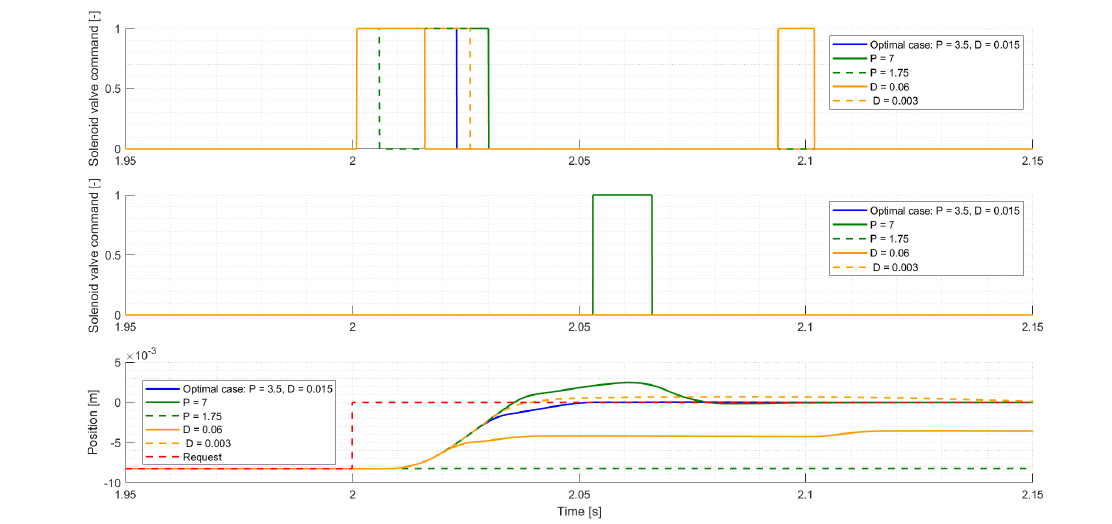
Figure 5. Effects of the P and D parameters in case of Low to Neutral gear